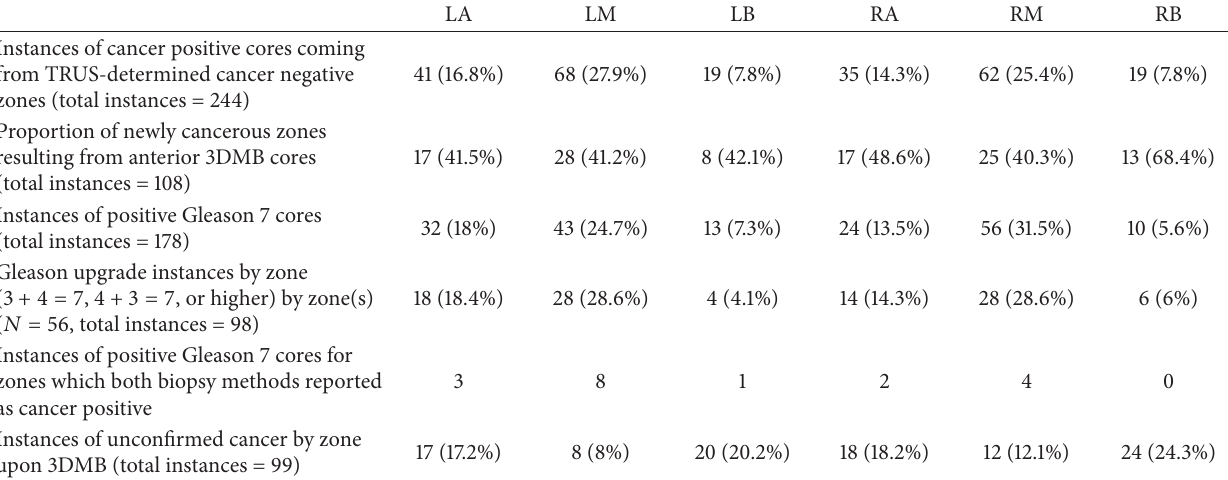
Table 3: Newly discovered cancers and cancer